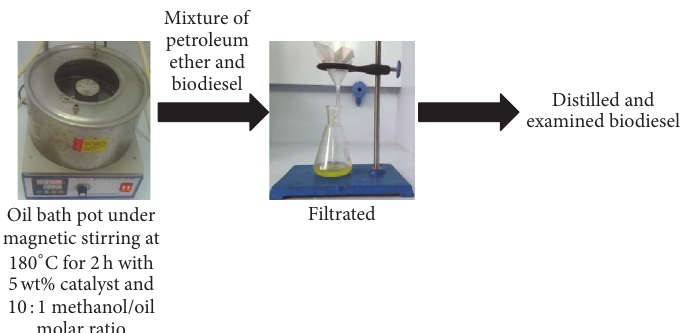
Scheme 1: Reaction schematic for biodiesel production.